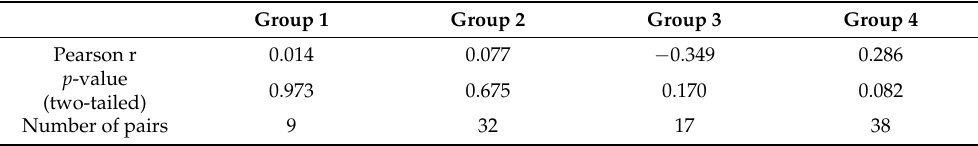
Table A5. Bonferroni–Holm-corrected p -values for the ratio of cfDNA/DNase activity.